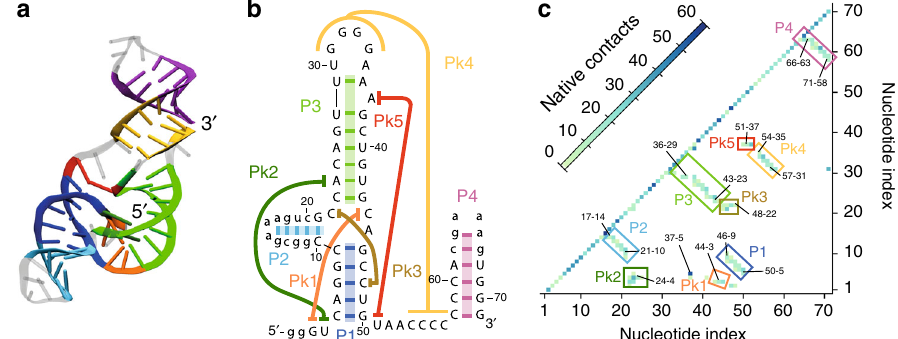
Fig. 1 Structural organization of Zika xrRNA. a Ribbon representation of the 71-nucleotide long xrRNA of the Zika virus, PDB entry 5TPY 3 . b Diagrammatic representation of canonical and noncanonical base pairings, as annotated by Barnaba 47 . c Heat map of the native contacts. The map includes heavy-atom interactions within a 4 Å cutoff distance and thus include contacts formed by bases, sugar, and phosphate moieties. The four helices, P1 – P4, and pseudoknotted regions, Pk1 – Pk5, are highlighted. Diagram in b follows ref. 3 . Secondary elements are highlighted with the same color code across the three panels. Structural renderings are based on the VMD software package 48